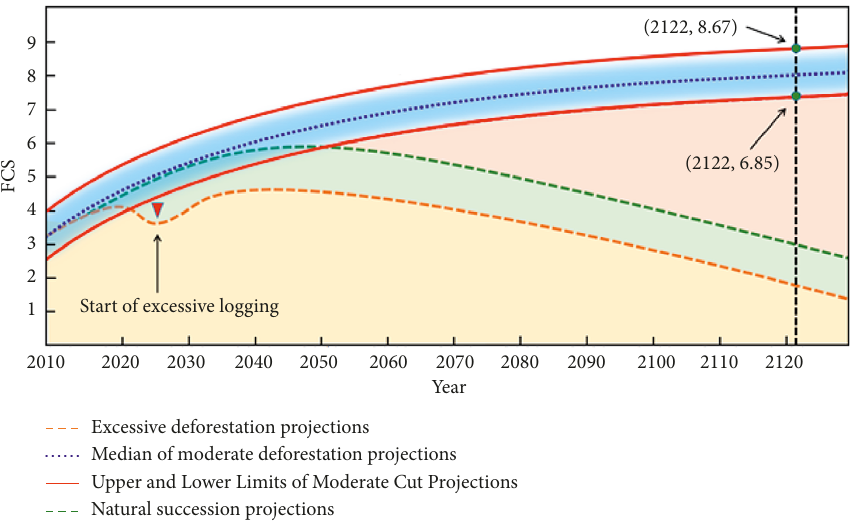
Figure 7: Projections of carbon sequestration from different forest management